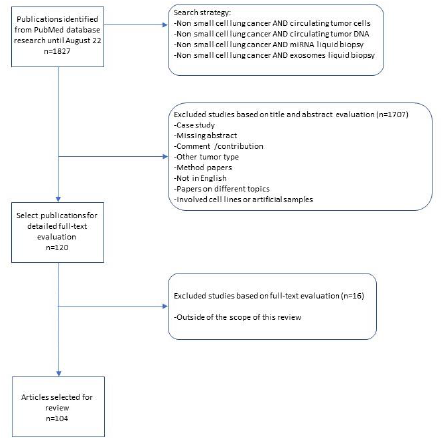
Figure 1. Flowchart of the literature selection.